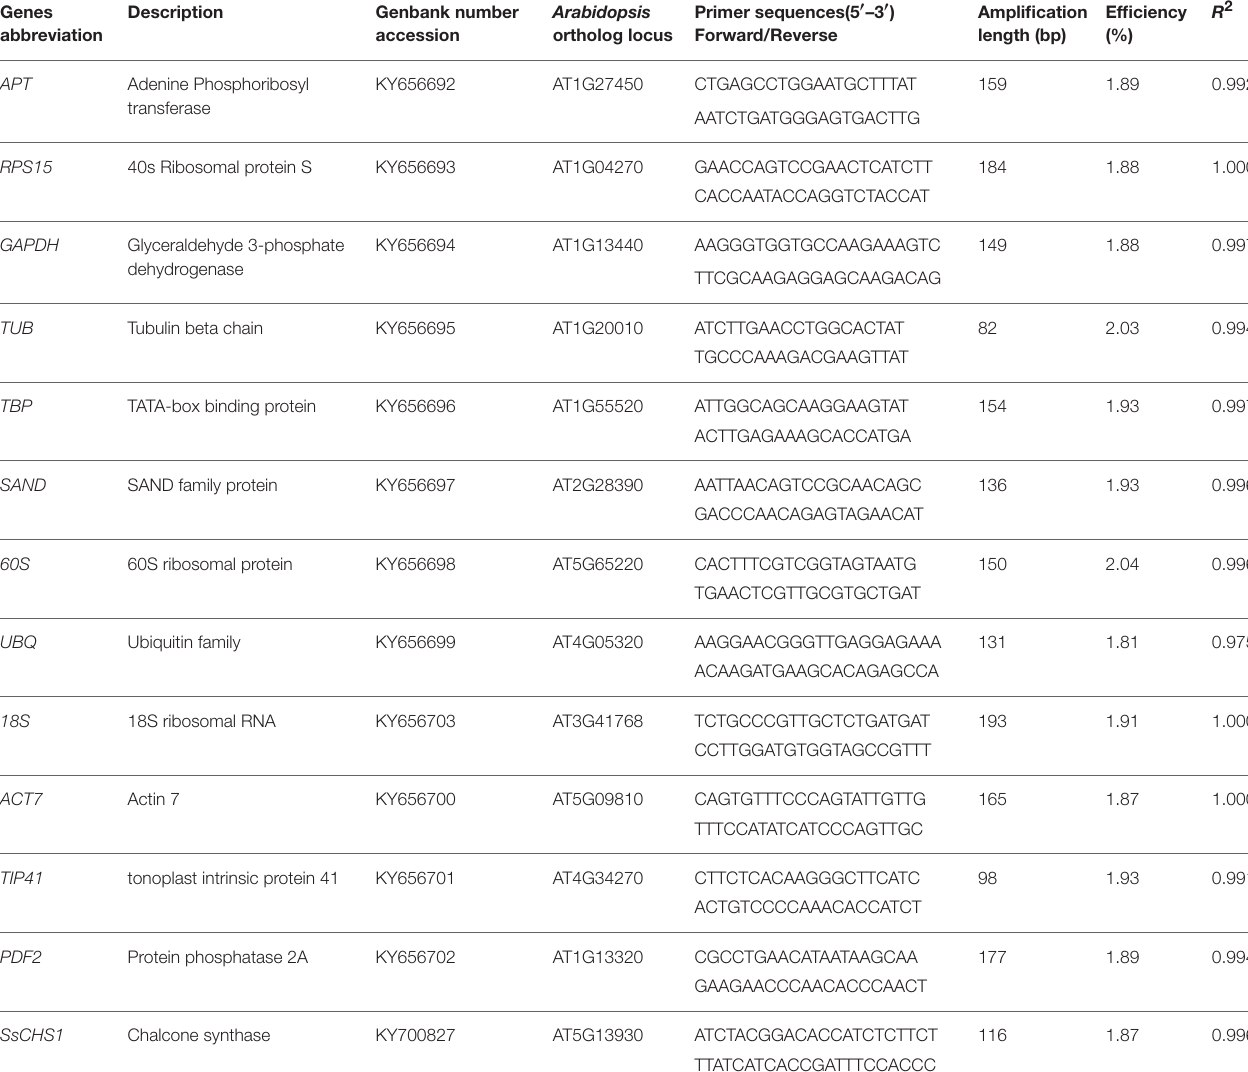
TABLE 1 | Genes description, amplification length, and PCR efficiency for Sapium sebiferum RGs